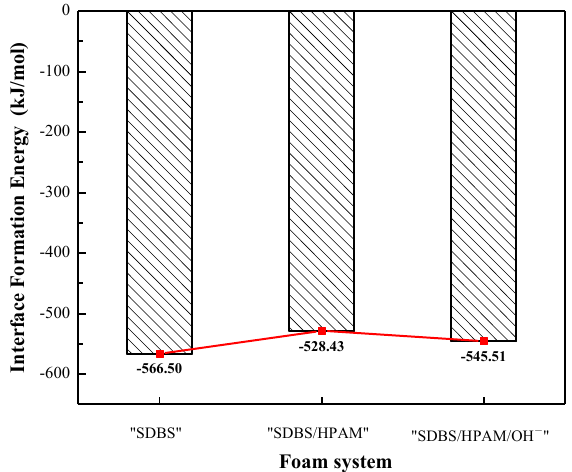
Figure 9. Interface formation energy in different foam systems.